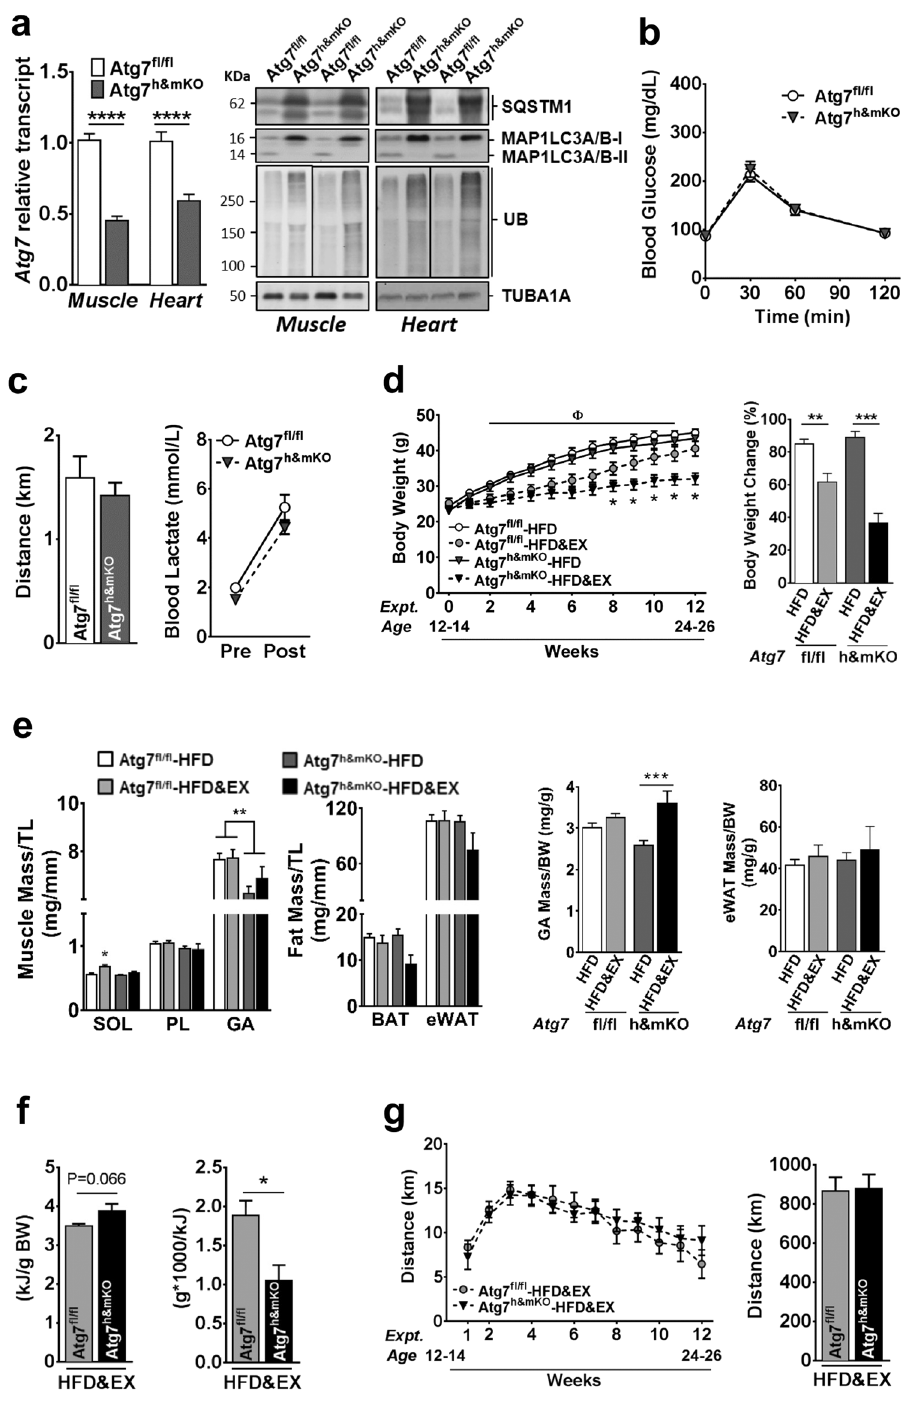
Figure 1. Diet-induced obesity in exercise-trained Atg7 h&mKO mice. ( a ) Atg7 mRNA and immunoblot representative images of the mean value for select autophagy and ubiquitinated proteins (UB) in muscle and heart (n = 11–15). ( b ) GTT (n = 14). ( c ) Distance run and blood lactate before (Pre) and after (Post) the endurance exercise capacity test (n = 11). ( d ) Body weight quantification and percentage change during the intervention (n = 8–11). ( e ) Muscle (Soleus-SOL, Plantaris-PL, Gastrocnemius-GA) and adipose (BAT and eWAT) masses normalized to tibia length (TL) and body weight (BW) (n = 6–11). ( f ) Average daily caloric intake, and feed efficiency (n = 6). ( g ) Weekly average of daily voluntary running activity, and total running distance during the intervention (n = 6). * P < 0.05, * * P < 0.01, *** P < 0.001 **** P < 0.0001 in comparison to all other groups, unless otherwise represented; Φ P < 0.05 both Atg7 fl/fl -HFD&EX and Atg7 h&mKO -HFD&EX in comparison to respective HFD only, sedentary